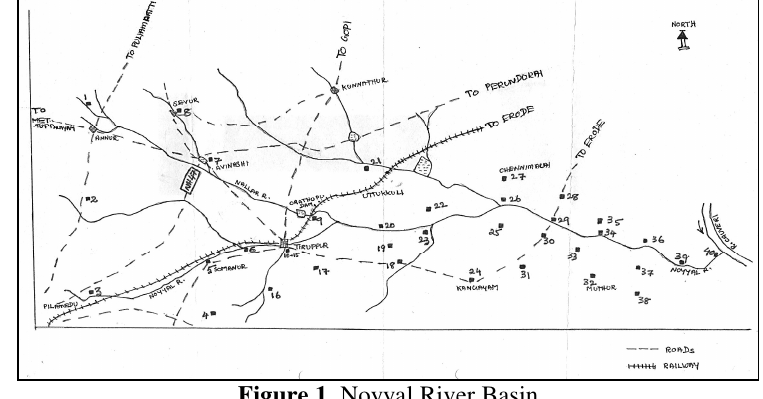
Figure 1. Noyyal River